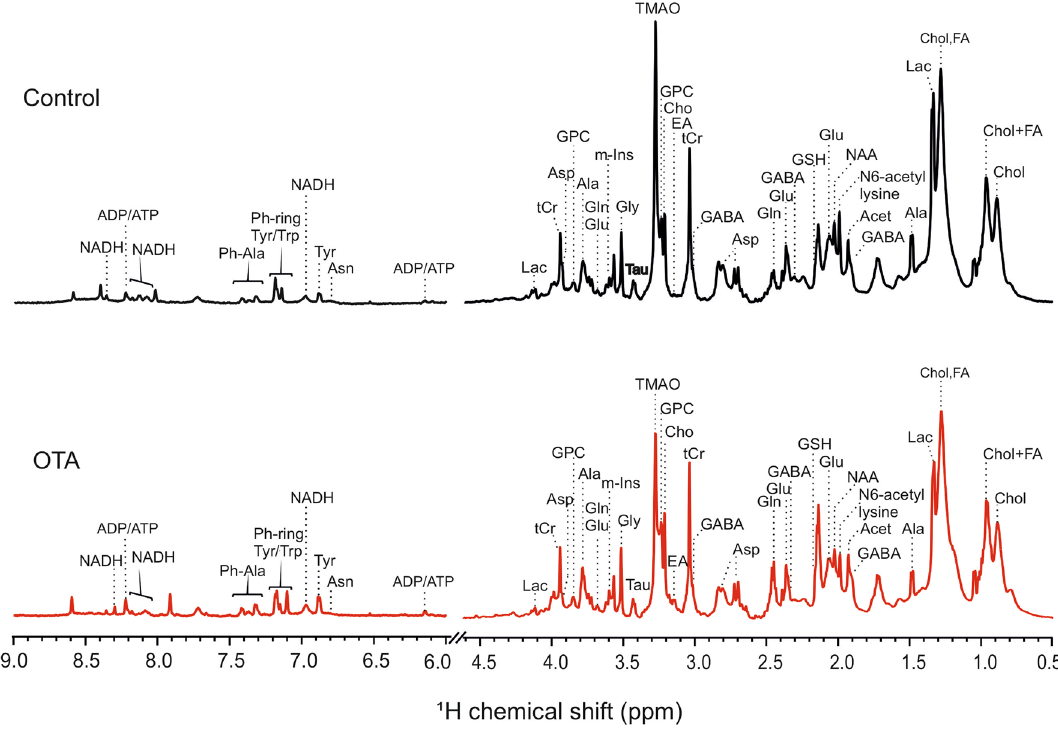
Figure 4. High-resolution magic angle spin (HRMAS) NMR based metabolic profiling. Representative HRMAS NMR spectra of ( A ) Control and ( B ) OTA (1 µM) exposed zebrafish embryos (72 hpf) treated for 24